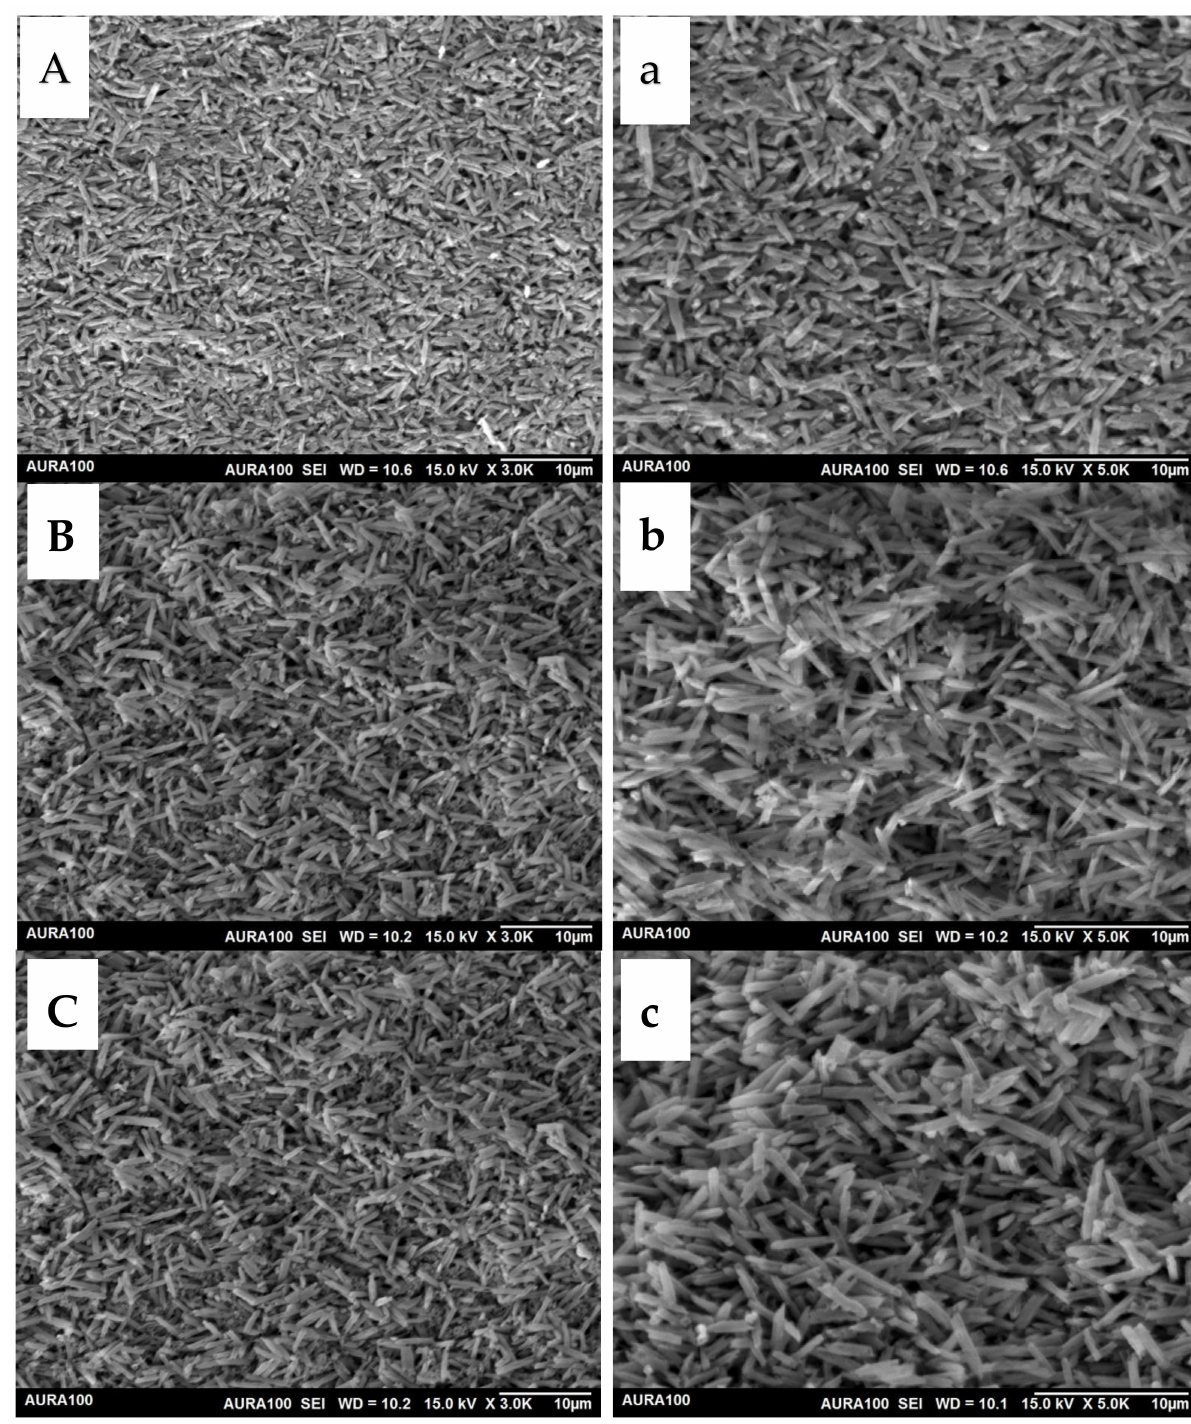
Figure 2. Scanning electron microscope images of each group, under 3000 × (left column) and 5000 × (right column) magnifications. The first press group ( A , a ) show closely packed and interlocked lithium disilicate crystals. The second ( B , b ) and third press groups ( C , c ) show larger and less densely packed lithium disilicate